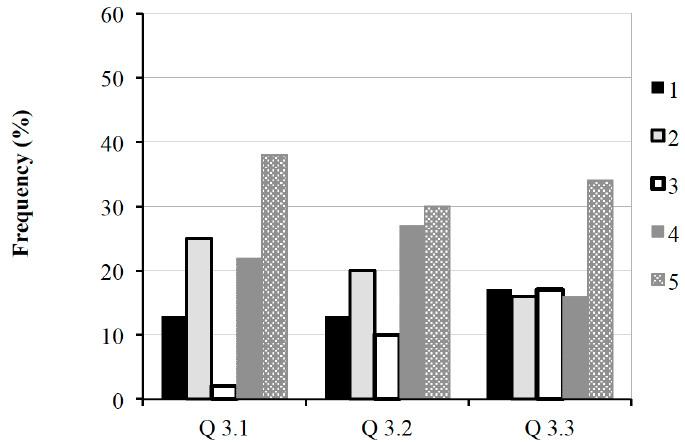
Fig. 3. Students’ responses to the questions of Section 3 in Questionnaire A presented on a five-point Likert scale, where 1 is the least value